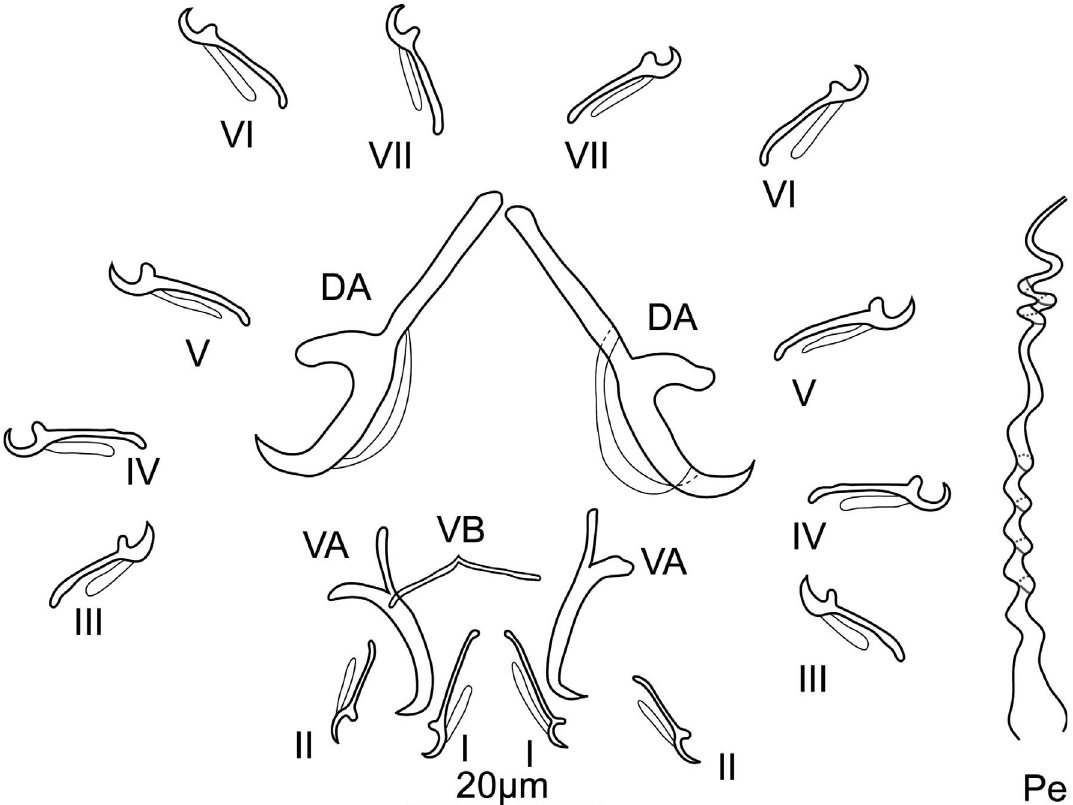
Figure 3. Drawings of sclerotized parts of E. coronatus Pariselle, Lambert & Euzet, 1991. DA, dorsal anchor; VA, ventral anchor; VB, ventral bar; Pe, penis; I – VII ,